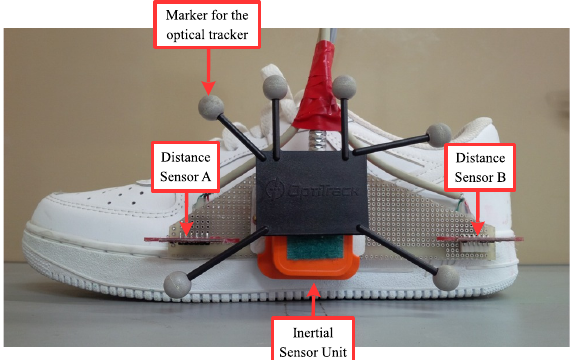
Figure 2. A shoe for the